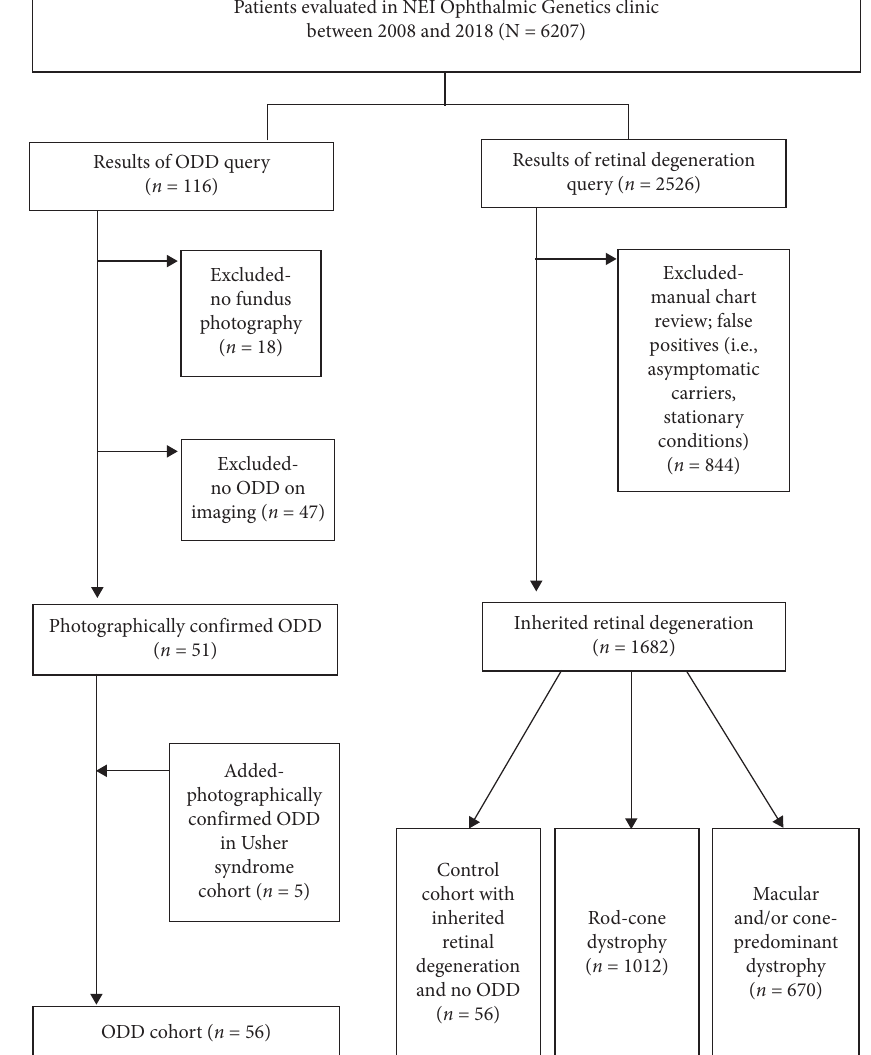
Figure 1: Flowchart depicting electronic medical record queries and